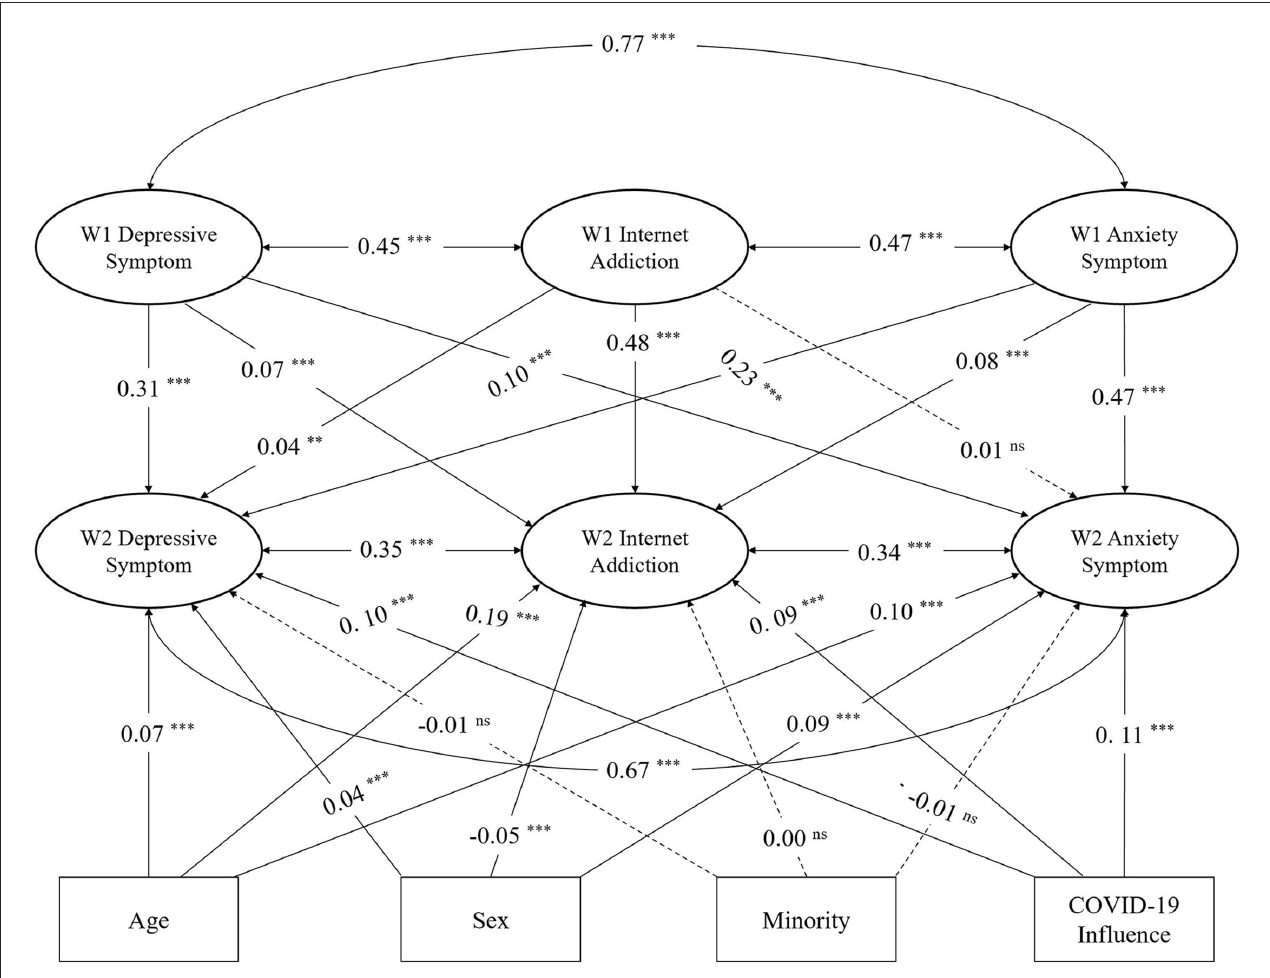
FIGURE1 The longitudinal cross-lagged model with bidirectional effects between internet addiction, depressive, and anxiety symptoms ( n = 7,958). (1) Dotted lines represent insignificant paths, ns = not significant. (2) ** p < 0.01, *** p <